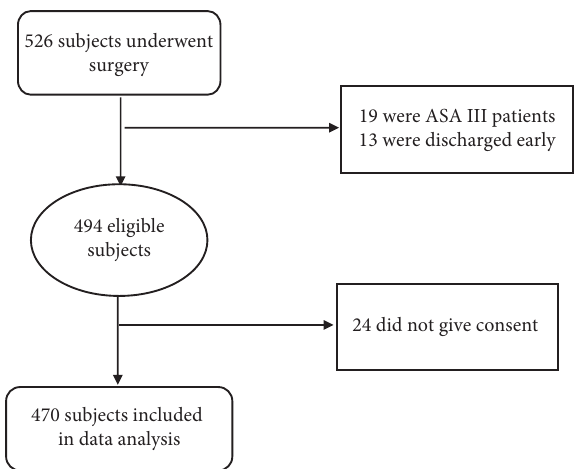
Figure 1: Eligible number of patients for the